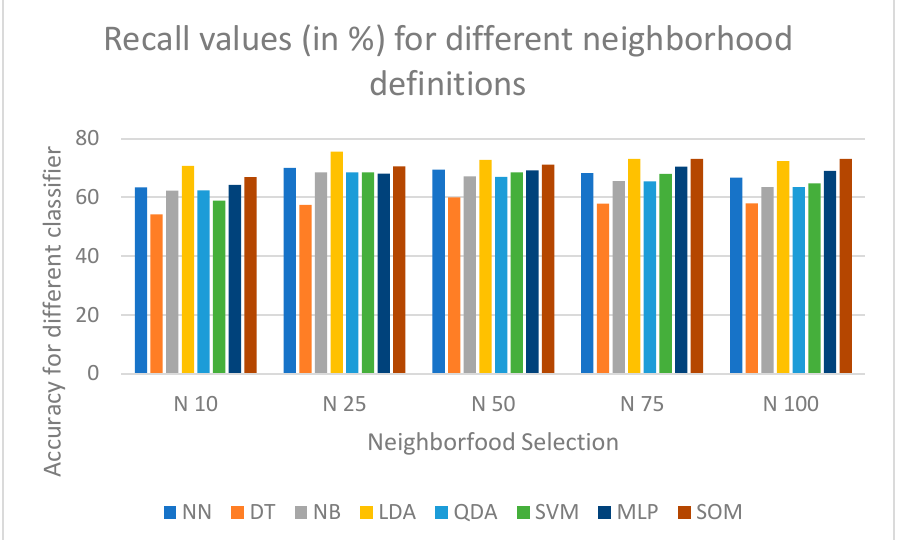
Figure 15. Recall Value for different neighborhood definitions.